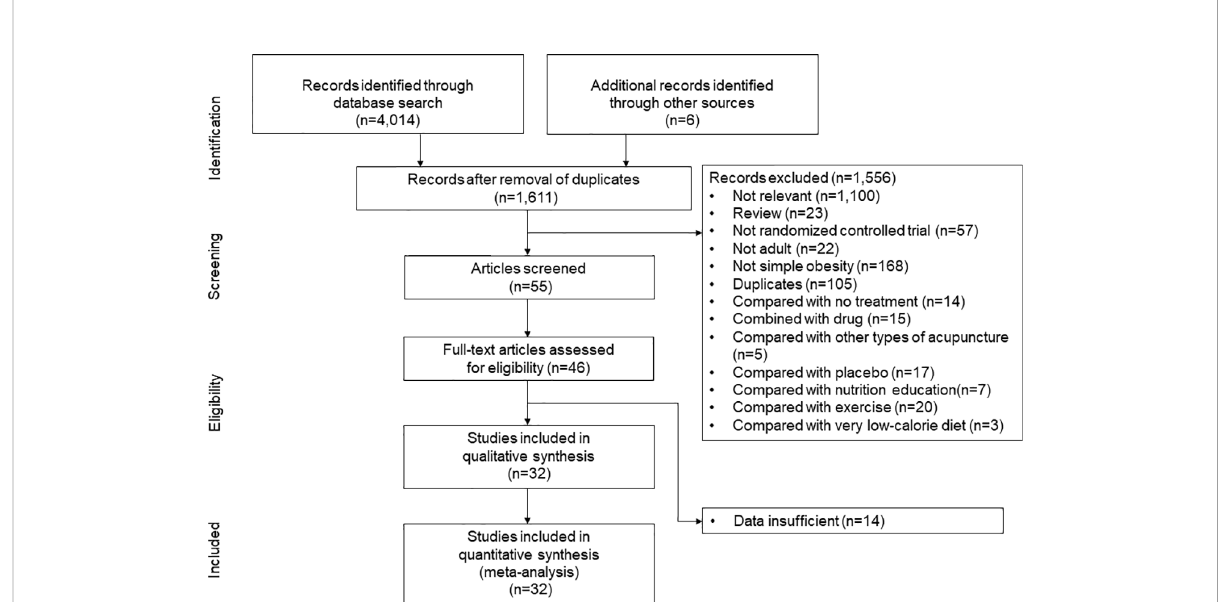
FIGURE 1 Study identi fi cation and selection. “ Compared with other types of acupuncture ” indicates the randomized controlled trials which compared the ef fi cacy of low-calrorie diet (LCD)-combined catgut embedding and LCD-combined electroacupuncture, or the ef fi cacy of LCD-combined acupuncture and LCD-combined catgut